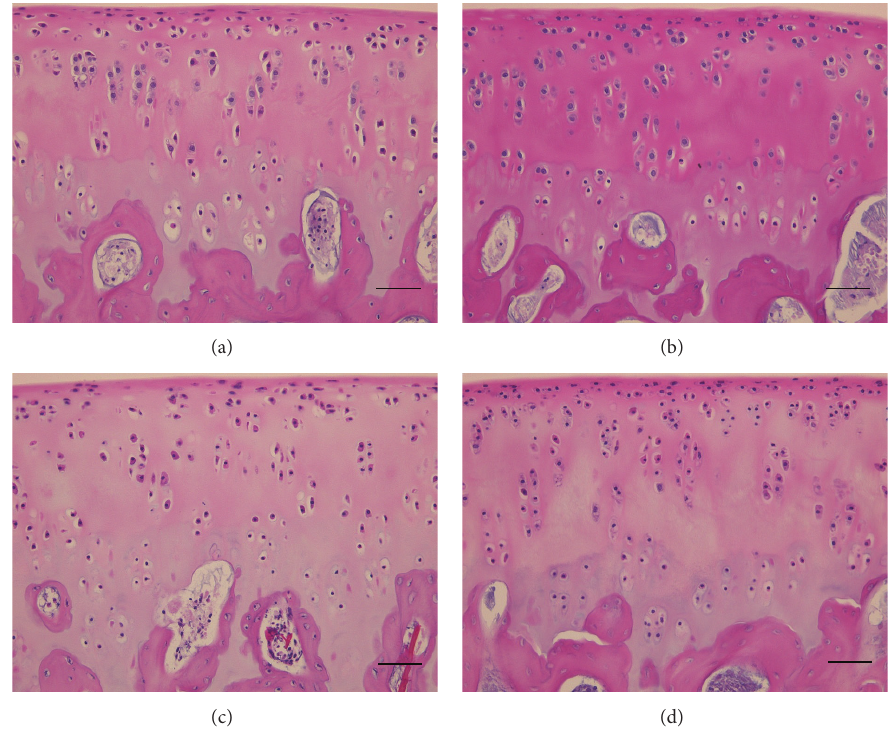
Figure 4: Representative hematoxylin and eosin-stained tissue sections of OCTs cold-preserved in the presence and absence of supplemental hydrogen. Histological analysis of OCTs was performed after 3 weeks of preservation in DMEM (a), DMEM with H2 (b), UW solution (c), and UW solution with H2 (d). Scale bar, 50 𝜇 m.